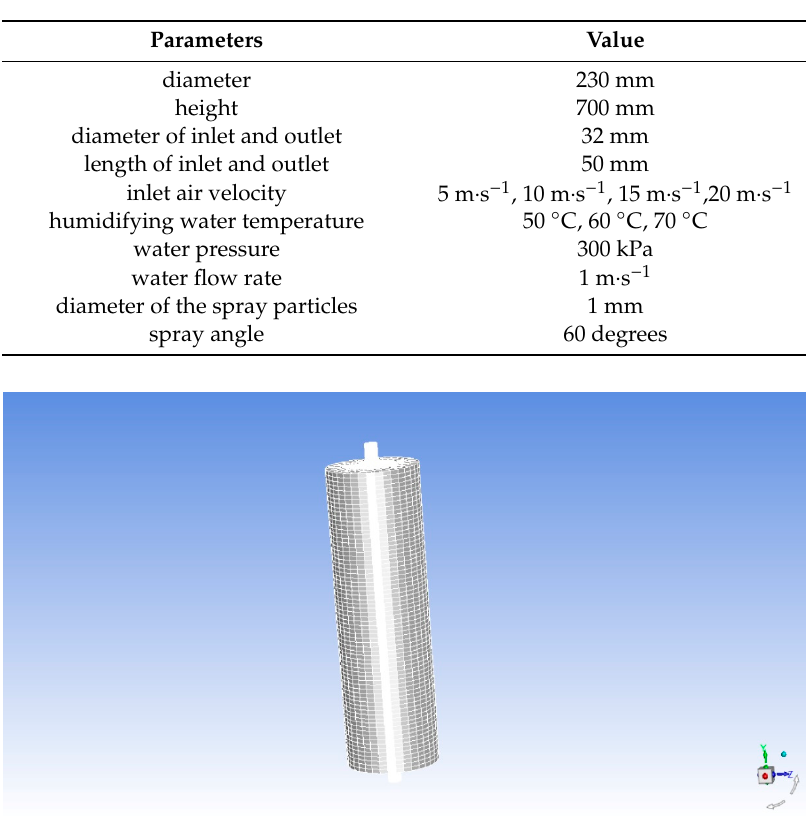
Figure 1. Computational domain grid of humidifier.